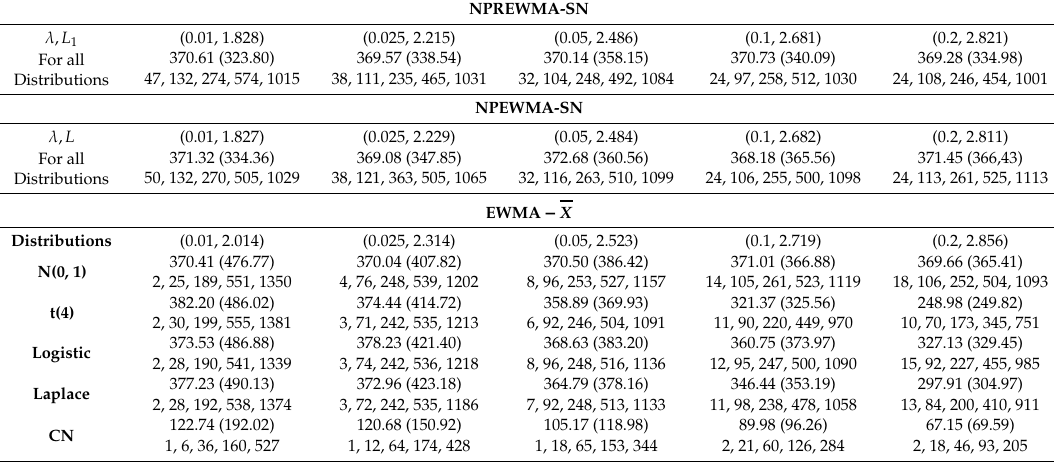
Table 4. IC RL profiles of the proposed and its competitor chart when m = 1 and n = 5. CN: contaminated normal distribution, EWMA: exponentially weighted moving average, NPREWMA: non-parametric exponentially weighted moving average based on sign statistics under a ranked set sampling